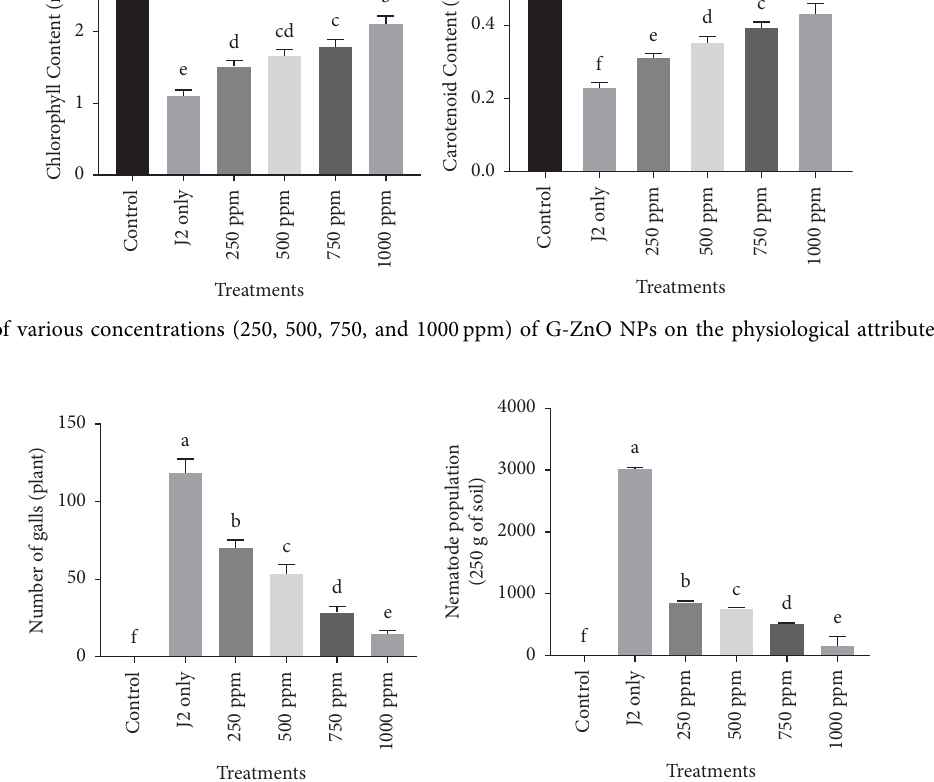
Figure 9: Efect of various concentrations (250, 500, 750, and 1000ppm) of G-ZnO NPs on the pathological attributes of chickpea. -0.5 0.0 0.5